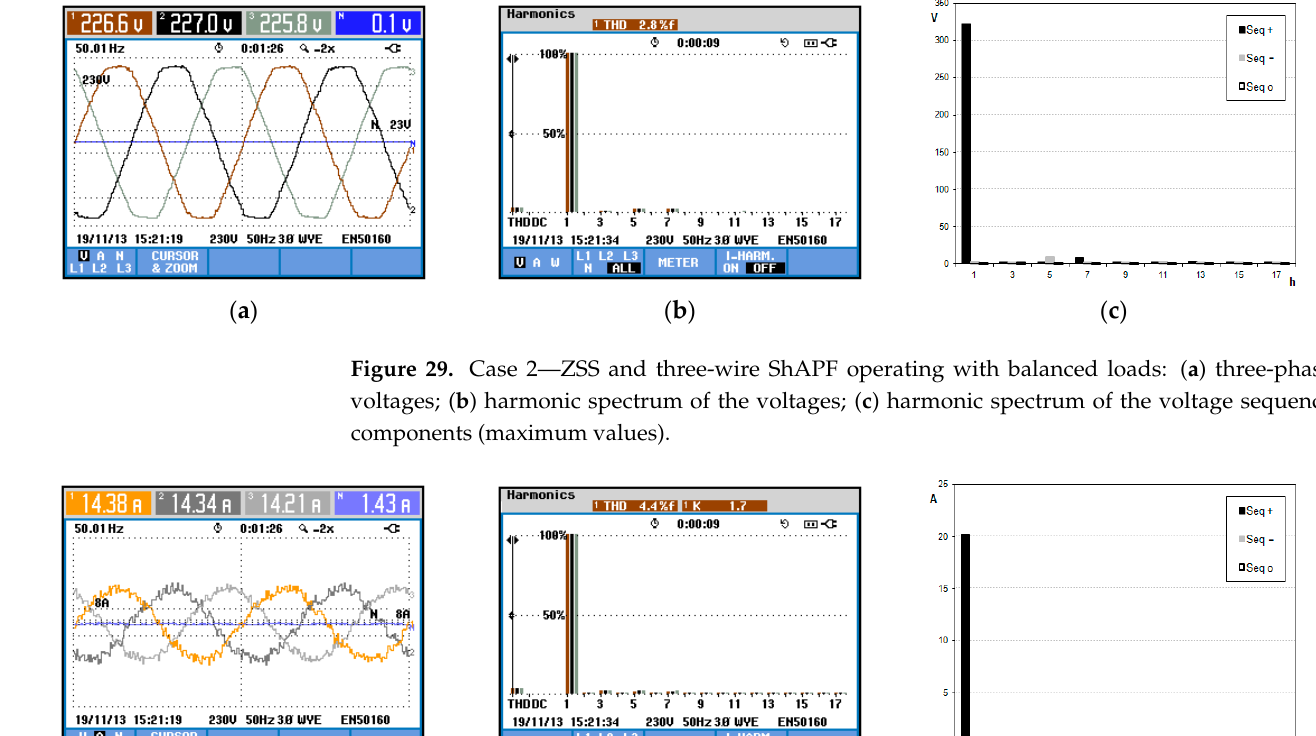
Figure 30. Case 2 - ZSS and three-wire ShAPF operating with balanced loads: ( a ) three-phase currents; ( b ) harmonic spectrum of the currents; ( c ) harmonic spectrum of the current sequence components (maximum values).